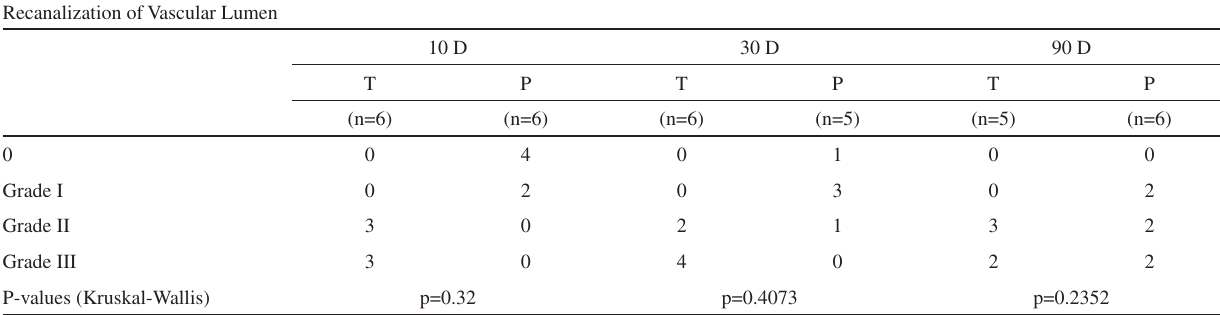
Table 3 - Recanalization of the vascular lumen related to the number of days after embolization with either trisacryl (T) or PVAc (P) Recanalization of Vascular Lumen